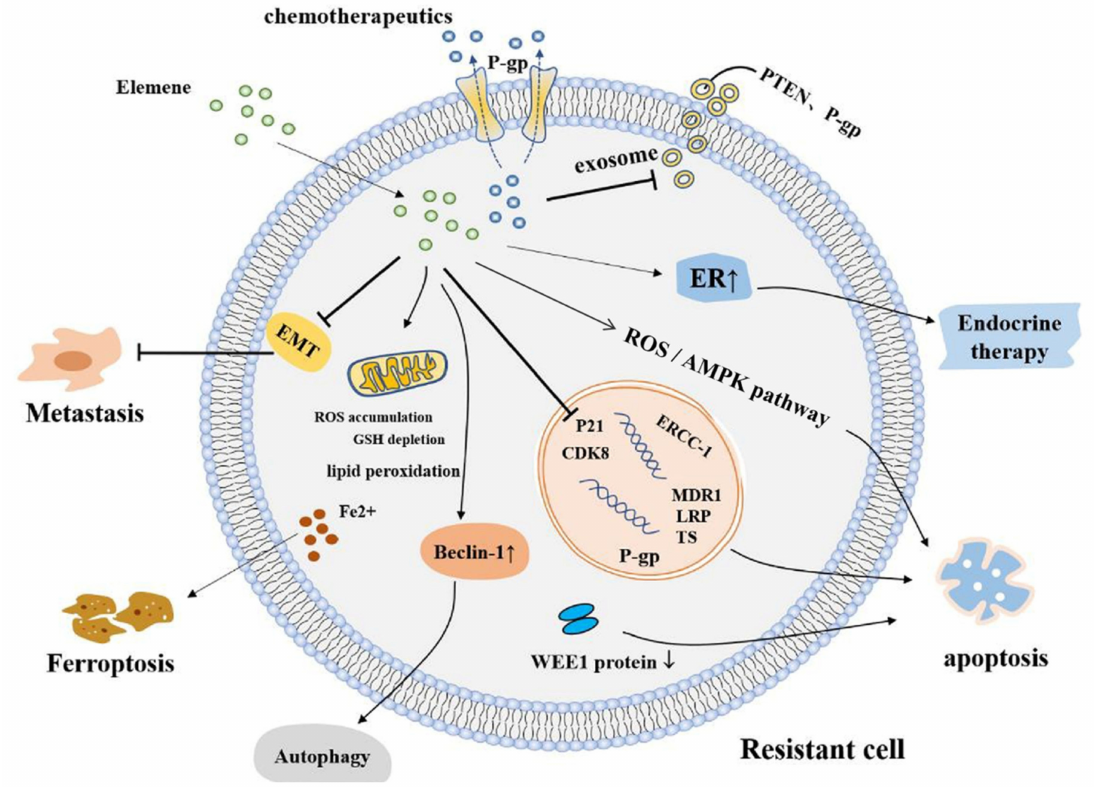
Figure 4. Classification of multidrug resistance mechanism of tumor cells reversed by elemene. The mechanisms of elemene reversing multidrug resistance include the induction of apoptosis, induction of iron death, induction of autophagy in tumor cells, inhibition of tumor cell migration, inhibition of the expression of P-gp efflux pump, inhibition of the expression of some MDR-related miRNAs in exosomes, and so on. The symble ↑ indicates upregulated expression. The symble ↓ indicates downregulated